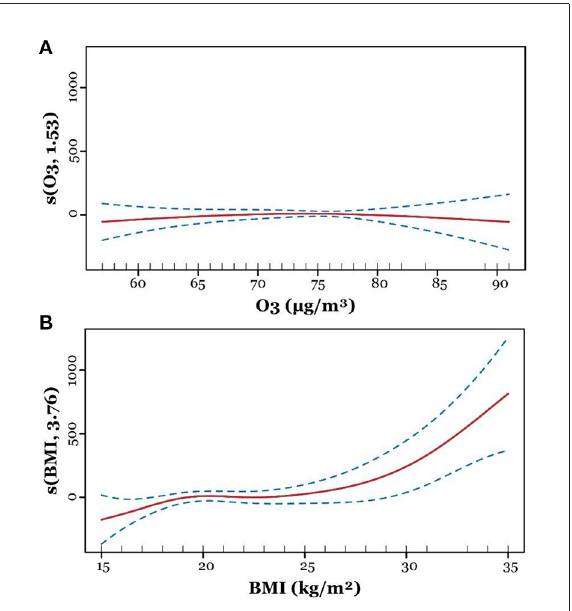
FIGURE3 Adjusted generalized additive model for ozone and body mass index (BMI). After adjusting confounders, the line plots show smoothing functions with 95% confidence intervals for the association between birth weight and ozone (A) and BMI (B) .